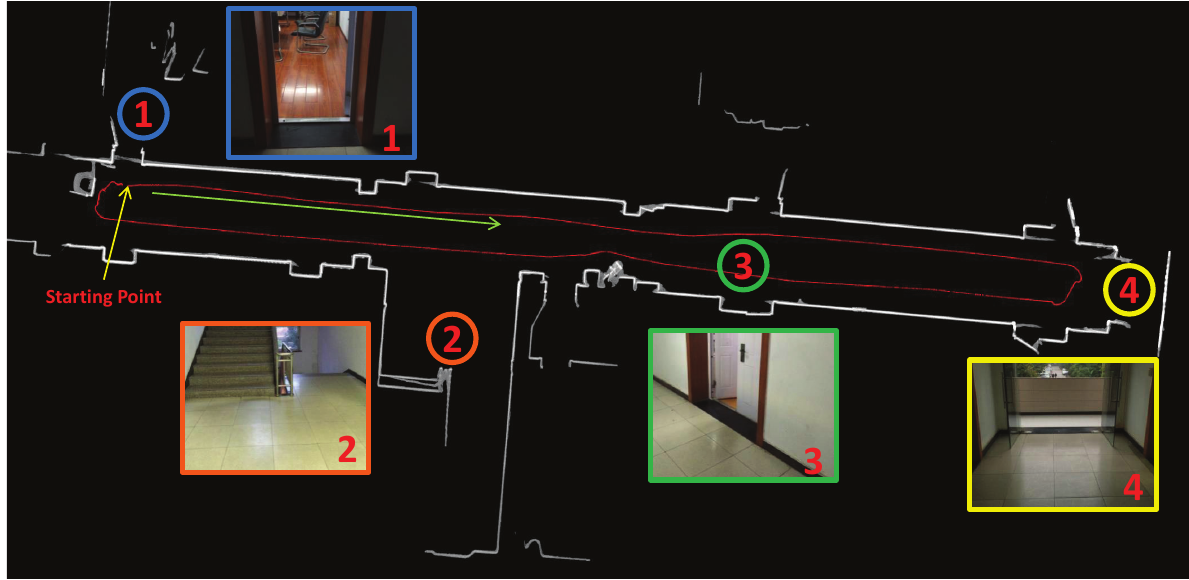
Figure 9: The occupancy likelihood map with a recovered moving trajectory (marked in red line) generated by our proposed SLAM algorithm in a narrow and long corridor with a length of about 100 m